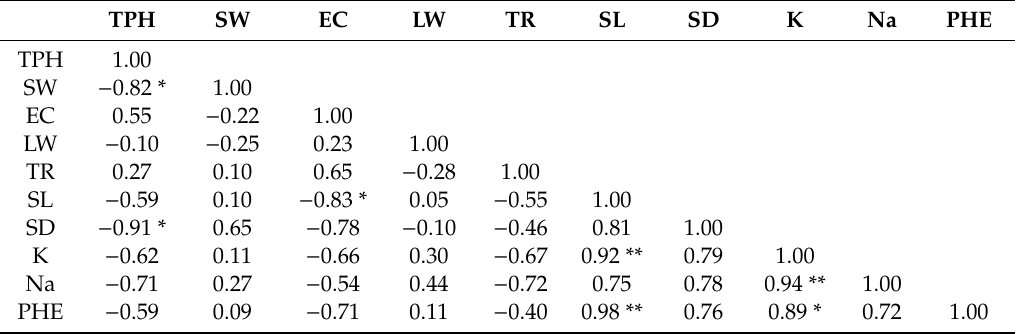
Table 1. Simple correlation coe ffi cient (r) between